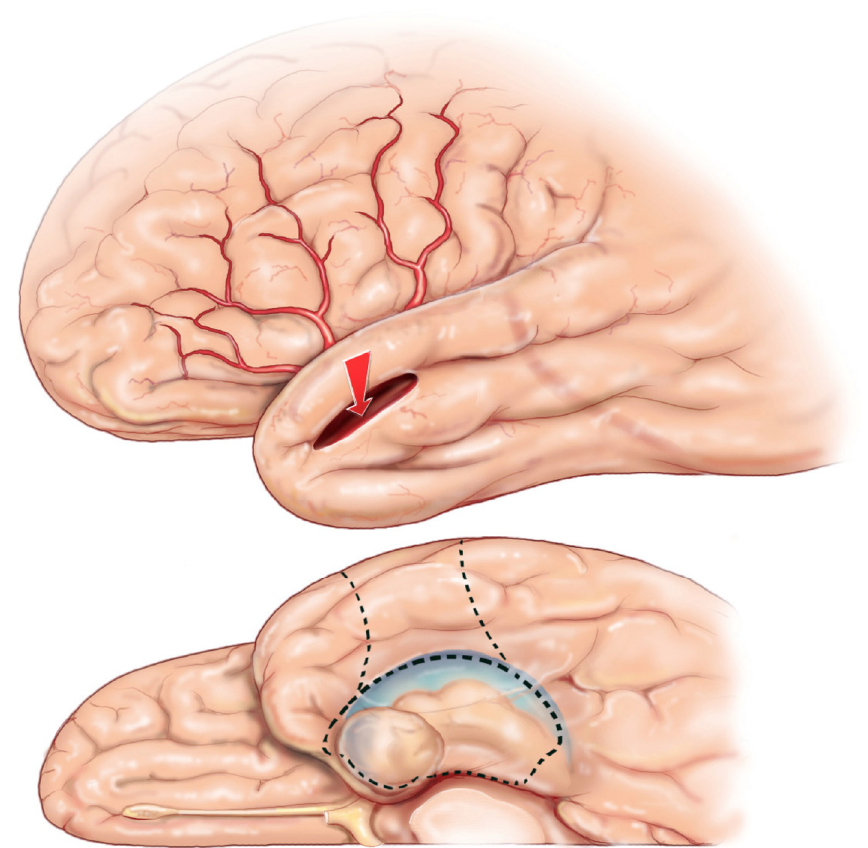
Figure 5. SAH corticectomy of about 2.5 cm is made along T2 just below the superior temporal sulcus. A white matter corridor is fashioned that follows the superior temporal sulcus down to the temporal horn, which is opened to visualize directly the mesial temporal structures.